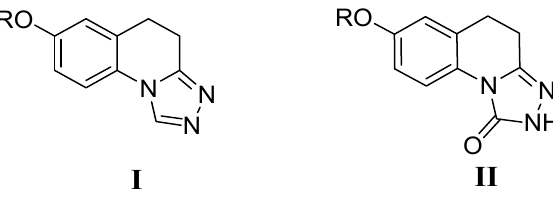
Figure 1. The structure of Lead compounds.